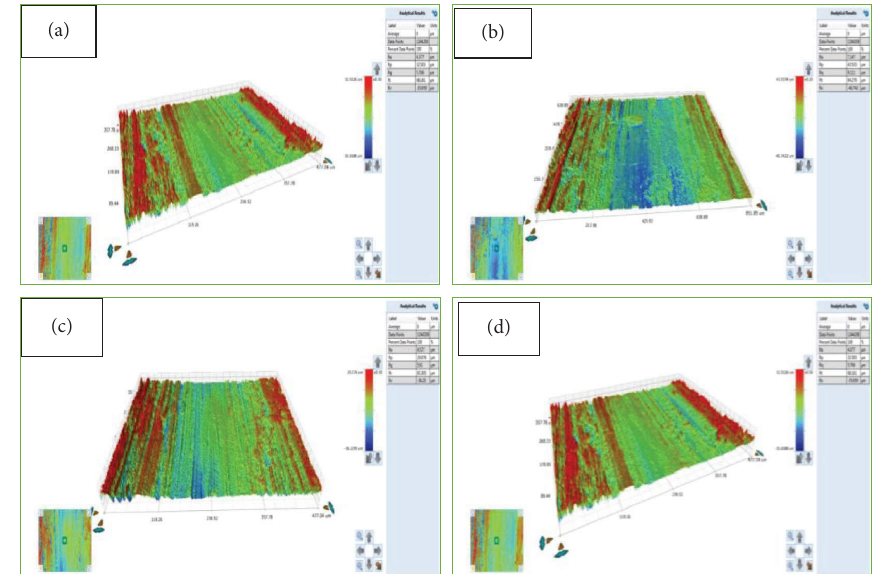
Figure 16: 3D proflometer image of HAlSi24 alloy under DLC coated condition at (a) 20N, (b) 30N, (c) 40N, and (d)